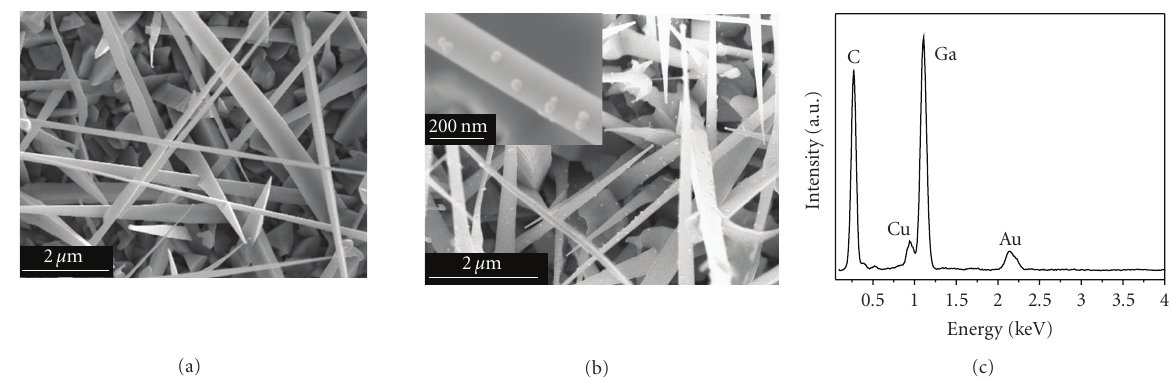
Figure 4: SEM images taken (a) before and (b) after growth of gold nanoparticles on GaN nanowires. (b) Gold nanoparticles can clearly be seen to decorate the surfaces of the GaN nanowires, the inset shows a close up of a single wire with multiple particles attached. (c) EDS of the particles taken by TEM confirms that they are